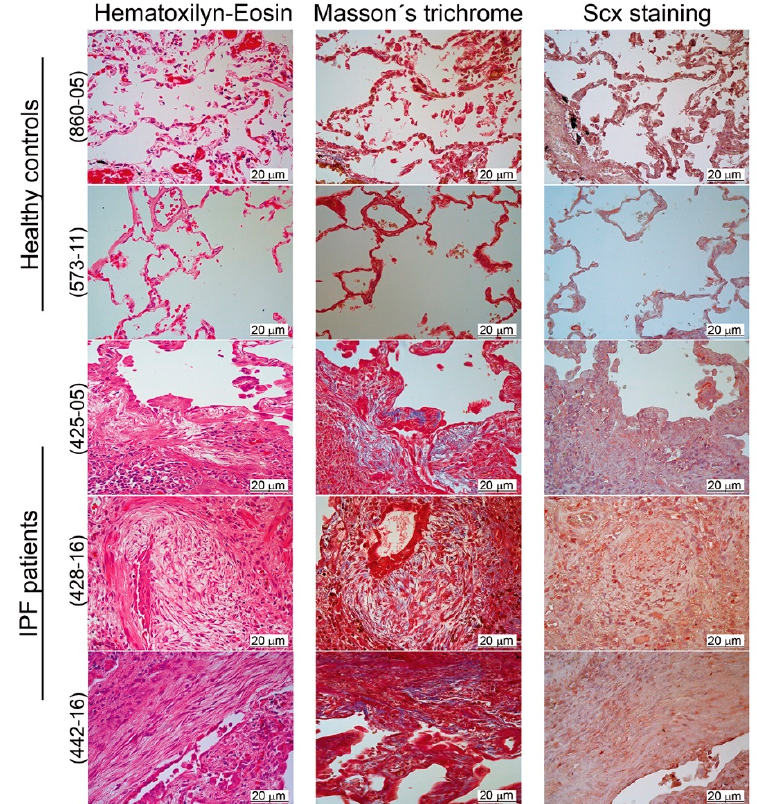
Figure 3. SCX expression was elevated in IPF tissue. Pulmonary tissue derived from IPF patients showed higher expression of SCX in comparison to healthy controls. Immunohistochemical analyses were made in two tissue samples from healthy controls (samples 573-11 and 860-05) and three IPF patients (425-05, 428-16, and 442-16). Samples were stained with hematoxylin–eosin and Masson’s trichrome. SCX was localized with a rabbit polyclonal antibody against human SCX (1:25; Antibodies online ABIN9670006). The fibroblastic foci in all IPF samples were localized in the center of each picture. In the hematoxylin–eosin stain, the fibroblastic foci were observed as pale areas composed of elongated cells, whose nuclei appeared stained with SCX (in the SCX stain). In the Masson’s trichome stain, the fibroblastic foci also showed blue coloring due to the presence of collagen.